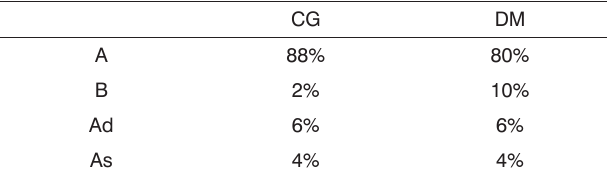
Table 1. Impedance test results for the control group (CG) compa- red against the diabetes mellitus group (DM); analysis of 100 ears from each group.